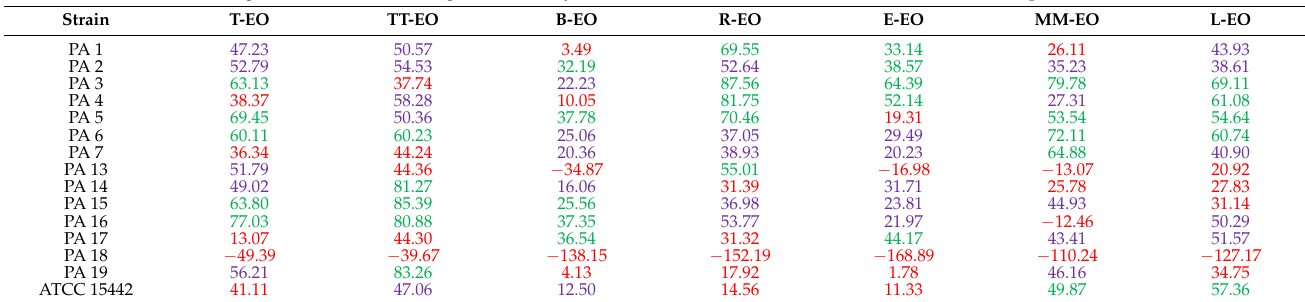
Table 5. Changes in the biofilm-forming cells viability (%) of P. aeruginosa clinical (PA 1–7, PA 13–19) and the reference (ATCC 15442) strains after treatment with non-emulsified essential oils in their liquid forms assessed with the A.D.A.M. (antibiofilm dressing’s activity measurement) method. T-EO, thyme oil; TT-EO, tea tree oil; B-EO, basil oil; R-EO, rosemary oil; E-EO, eucalyptus oil; MM-EO, menthol mint oil; L-EO, lavender oil. The strains were grouped by their susceptibility to the particular oil. The groups are marked as follows: red, lowest susceptibility; purple, moderate susceptibility; green, the highest susceptibility among the tested strains. The negative values indicate an increase in biofilm-forming cells viability after their treatment with EOs in comparison to the growth control (untreated cells).